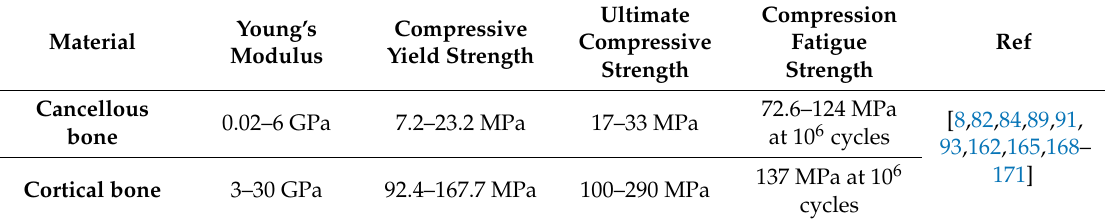
Table 6. Summary of mechanical properties of natural human